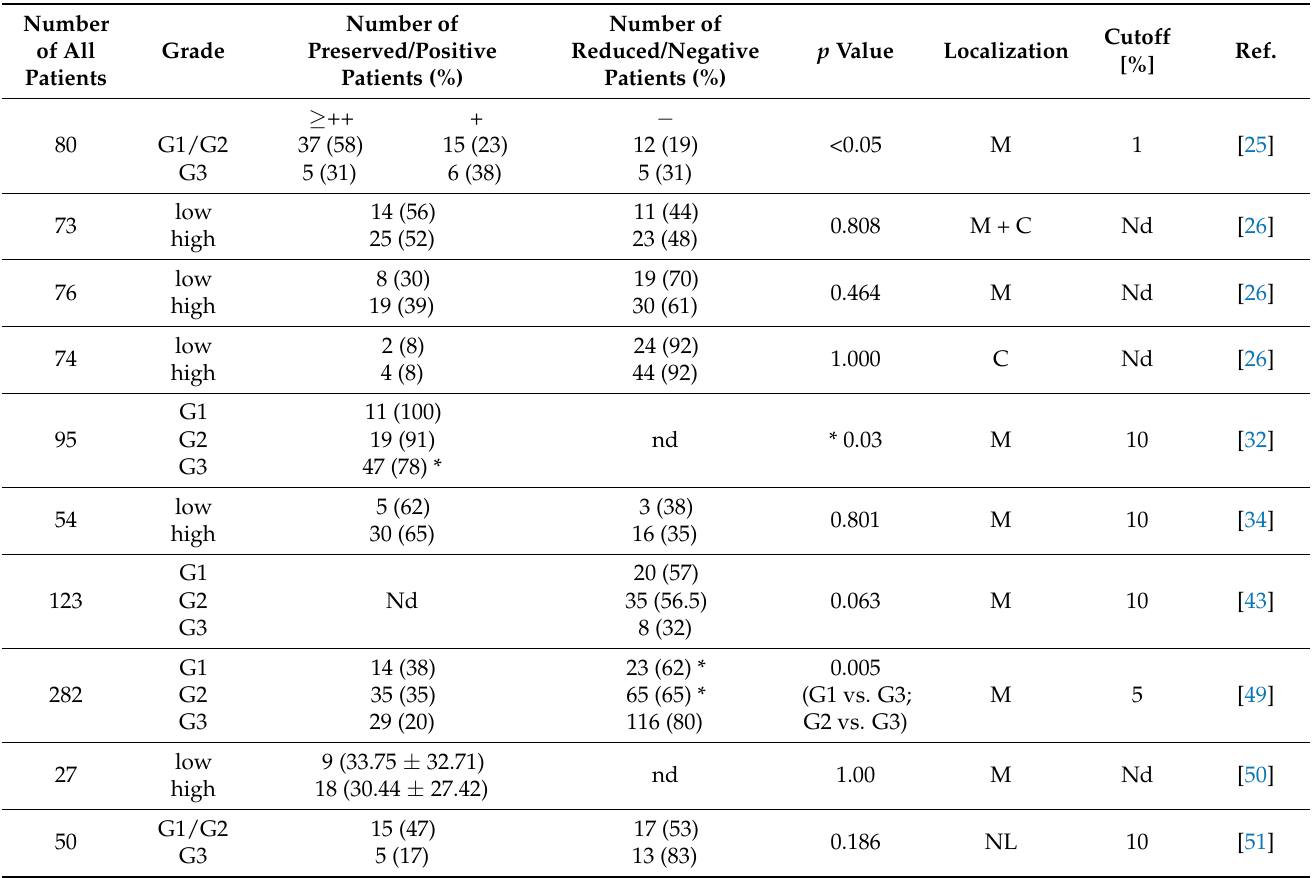
Table 4. The association of E-cadherin expression with tumor grade of EOC